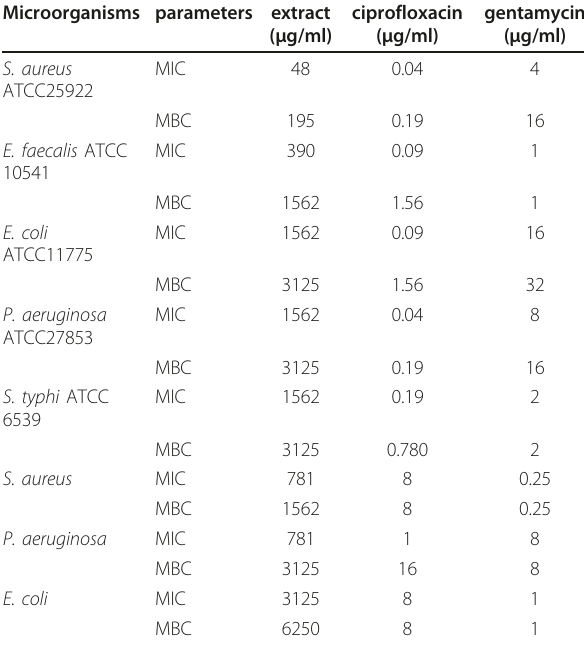
Table 1 Antibacterial activity (MIC, MBC) of the ethyl acetate extract from C. bauchiense